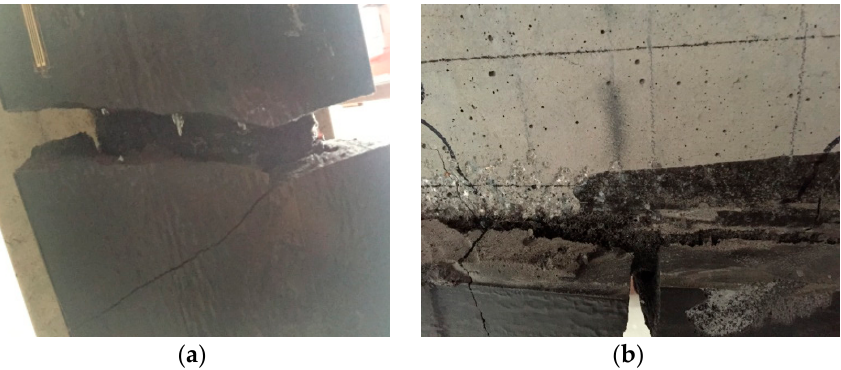
Figure 6. Flexural failure. ( a ) Bottom transverse fracture; ( b ) CNFPUC is separated from the concrete.